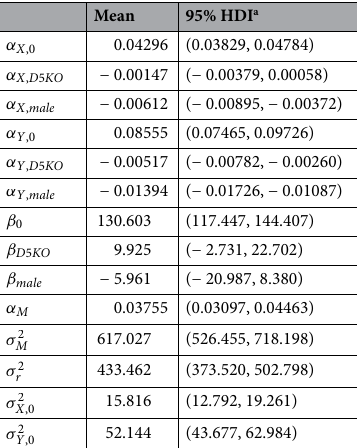
Table 1. Estimated parameters of the q-learning model. It is noted that α X , D 5 KO , α X , male , α Y , D 5 KO , and α Y , male were sampled from real numbers, while the other parameters were sampled from positive real numbers. a HDI represents the highest density interval.